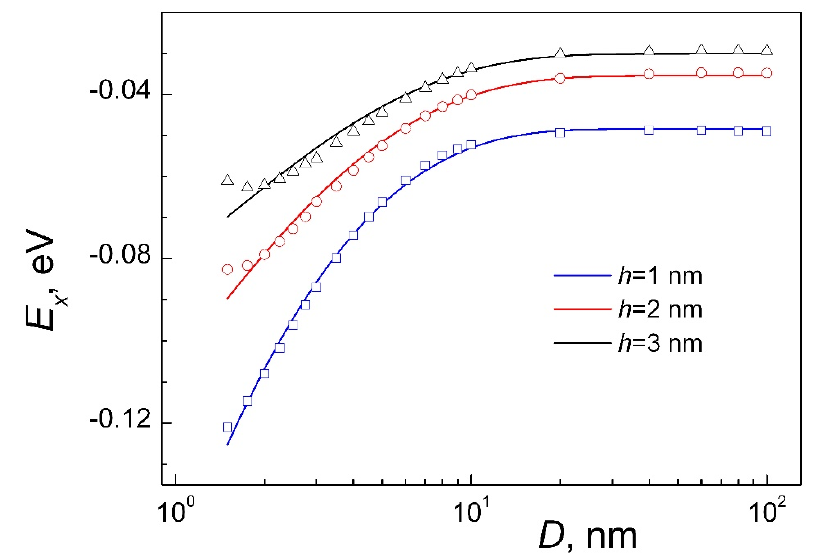
Figure 1. Binding energy E x of the SIE formed by an electron and hole located in neighbouring parallel NWs of diameter D separated by the distance h . Symbols (triangles, circles, and squares) – results of calculations for m h = 5 · m e and effective dielectric constant ε = 4, as described in Appendix A. Solid lines show the corresponding approximations by Equation (1) (see text) with the fit parameters: α = 6.4 nm, β = 0.23 nm −1 for h = 1 nm; α = 8.1 nm, β = 0.19 nm −1 for h = 2 nm; and α = 8.9 nm, β = 0.18 nm −1 for h = 3 nm.